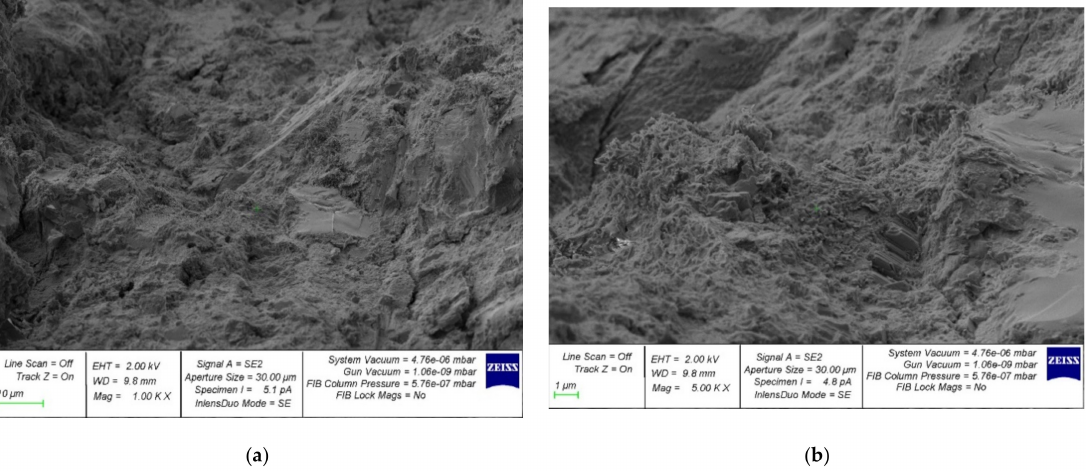
Figure 17. Photographs of the microstructure of a sample of hardened cement paste with dispersed reinforcement with coconut fibers in an amount of 1.75% by weight of cement: ( a ) 1000 × ; ( b ) 5000 × .